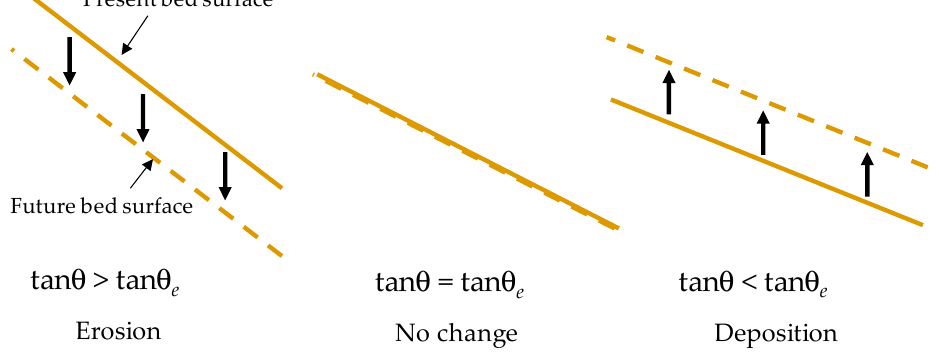
Figure 1. Relationship between bed deformation and bed slope.